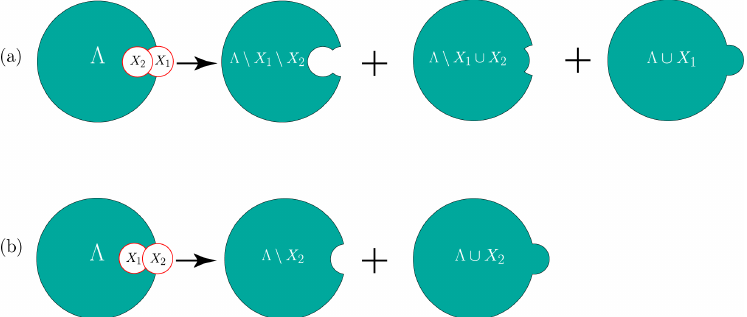
Figure 4: The figure shows how different orderings of the same domains ∈ ¯ S can give different results. In ( a ) , ¯ S X i